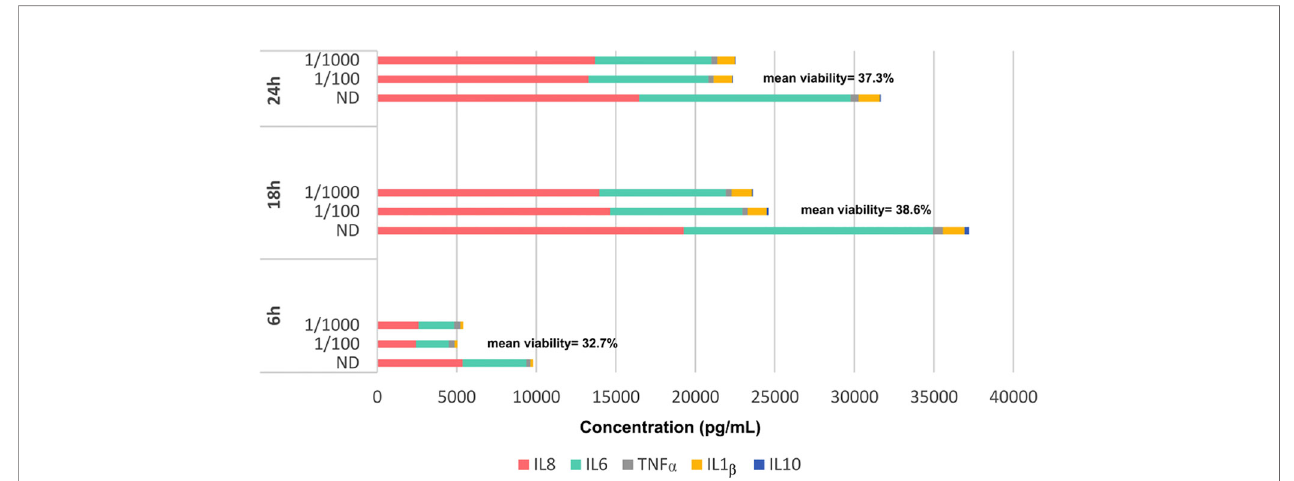
FIGURE 1 | Cytokine production of lymphoid cells obtained from a peripheral blood sample of a healthy volunteer under different incubation times (6, 18 and 24 h) and different dilutions of the fecal supernatant [non-diluted (ND), 1/100 and 1/1000]. Mean cell viability measured at each time is also